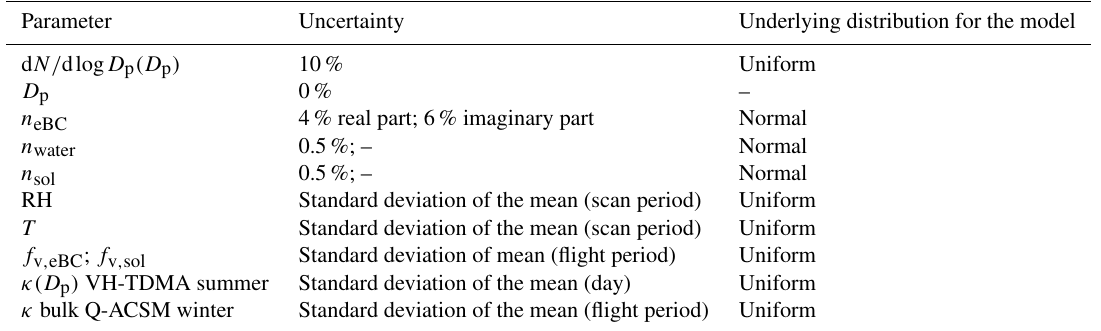
Table A2. Overview of the input parameters of the Mie model, the corresponding assumed uncertainties, and the underlying type of distri- bution for the variation of the input